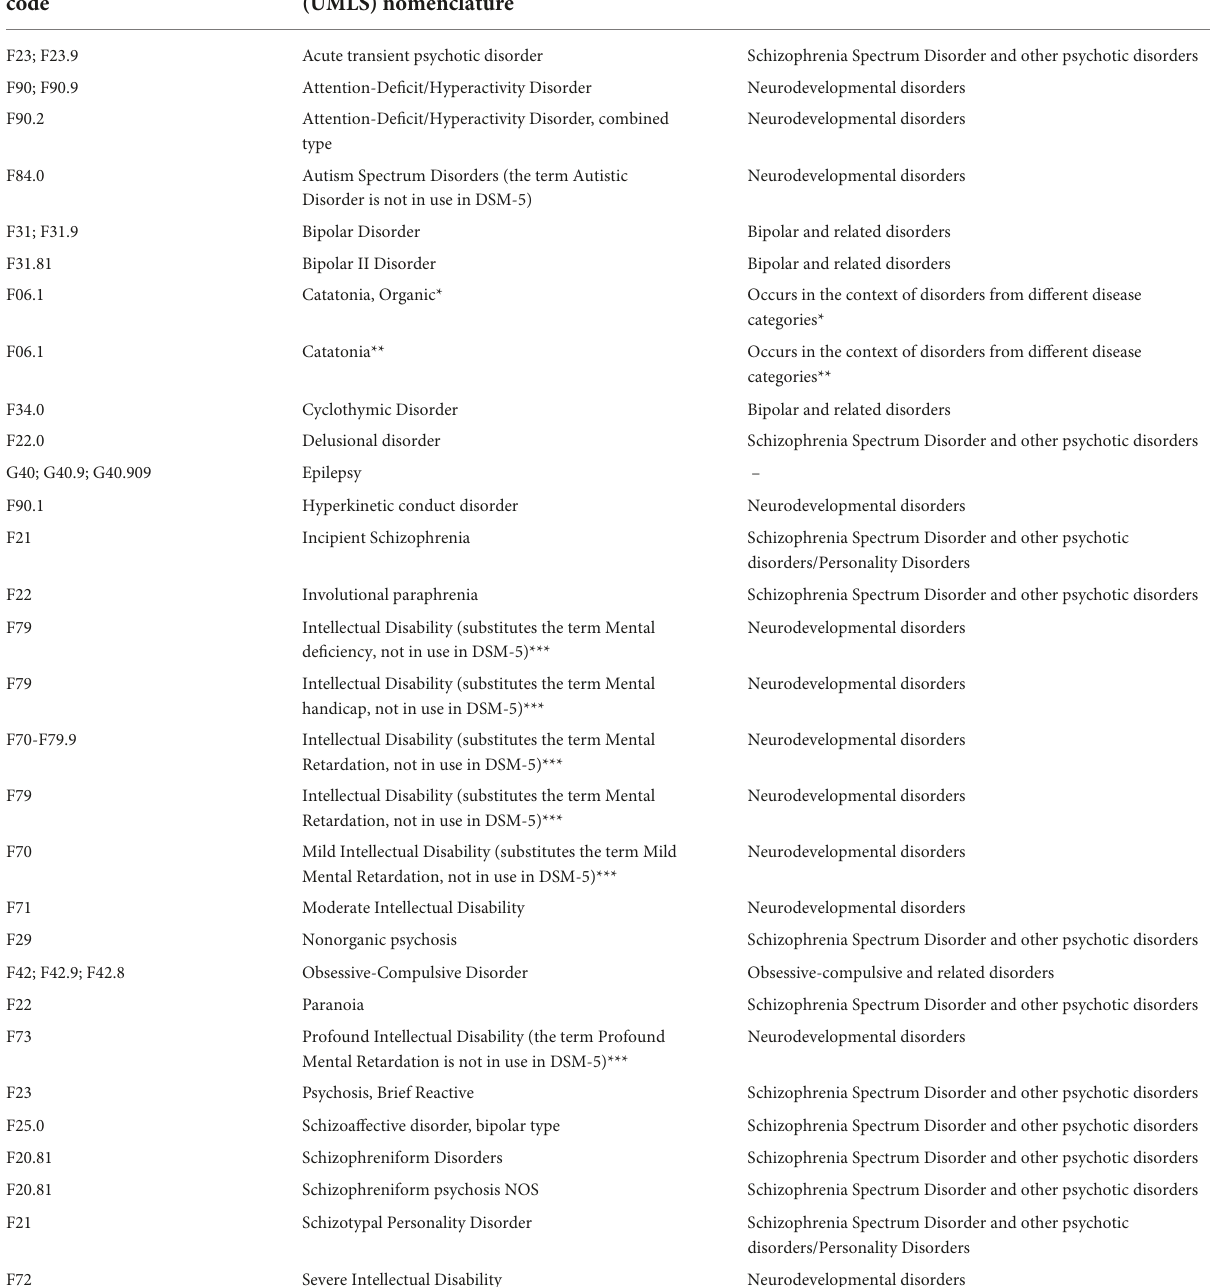
TABLE 1 Disease terms selected according to the International Classification of Diseases ICD-10/ICD-10-CM codes (the latest release, ICD-11, is not yet available in DisGeNET), the medical coding system designed by the World Health Organization to catalog health conditions by categories of similar diseases under which more specific conditions are listed. All the disease categories were obtained from the DSM-5, except Epilepsy, which is a neurologic disorder. ICD-10/ICD-10-CM